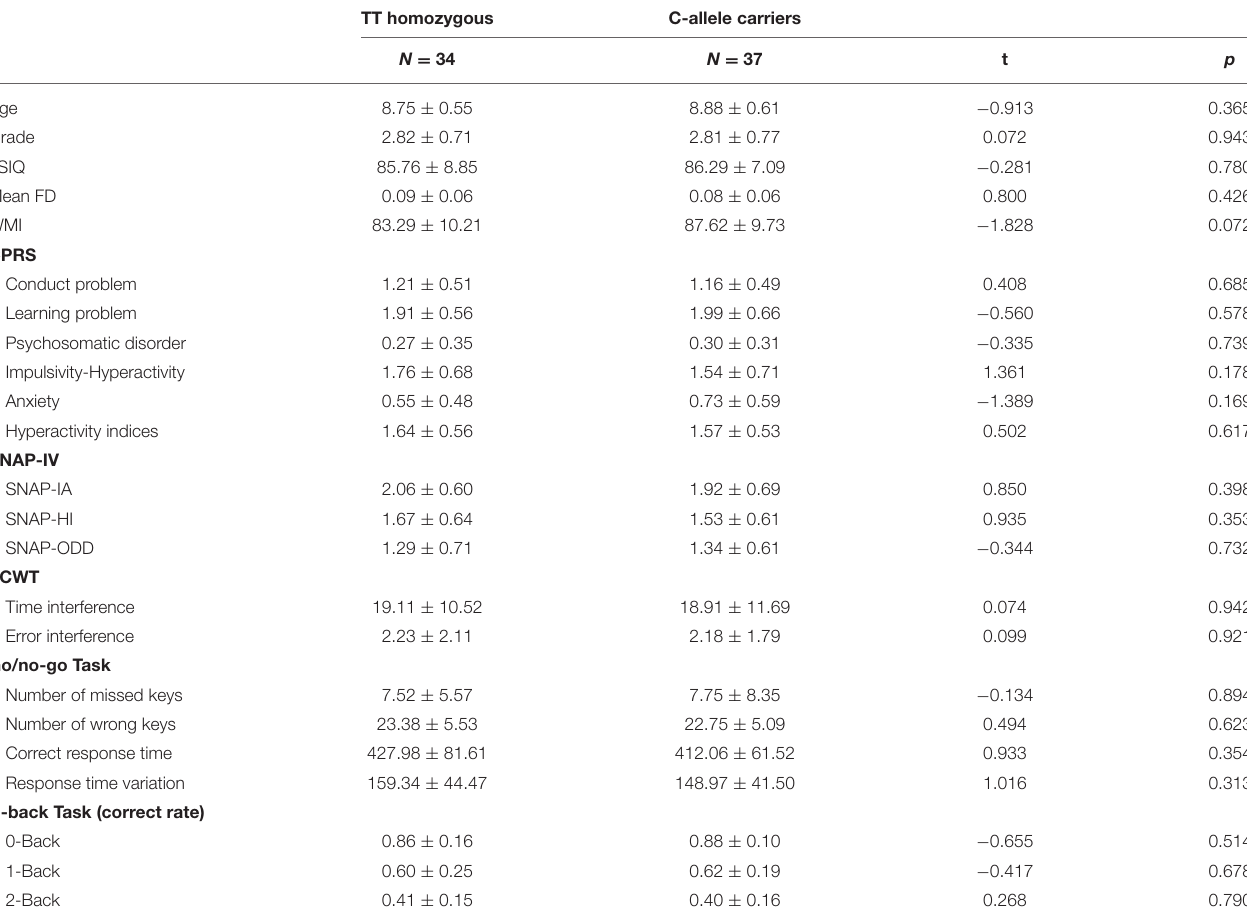
TABLE 1 | Demographic and clinical characteristics of children with ADHD in the two